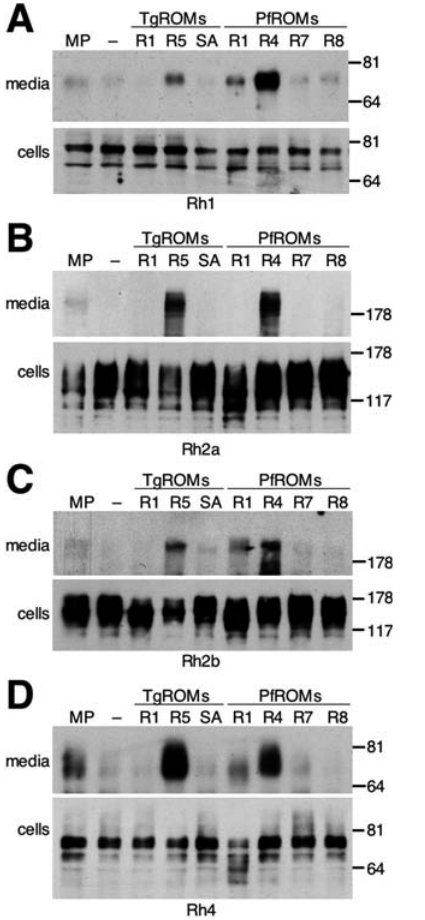
Figure 5. Cleavage of Rh Proteins by Parasite Rhomboid Enzymes GFP-tagged Rh1 (A), Rh2a (B), Rh2b (C), and Rh4 (D) were tested for cleavage by rhomboid enzymes by analyzing conditioned media with anti-GFP from transiently transfected COS cells. TgROM5 and PfROM4 readily cleaved each Rh protein, while PfROM1 could not cleave Rh2a but cleaved other Rh proteins at a lower efficiency. Note that in many cases smaller GFP-Rh protein breakdown products were readily detected in conditioned media (unpublished data). Molecular weight standards in kDa are denoted to the right of each panel. DOI: